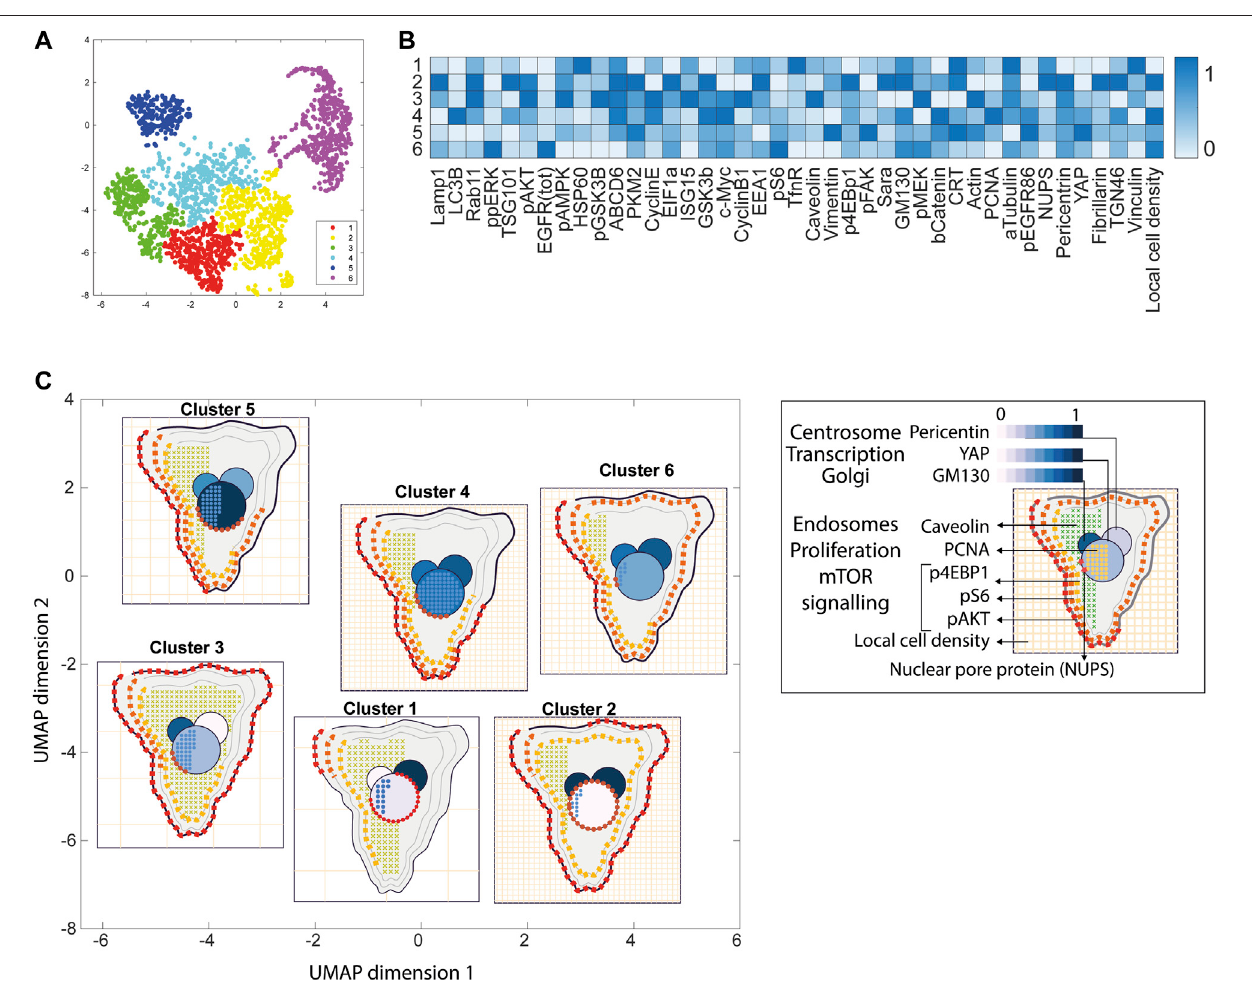
FIGURE 4 | ShapoGraphy allows interpreting multiplexed single-cell data. (A) UMAP projection of 2000 single HeLa cells. (B) Representation of average values of 40markersaswellaslocalcelldensityforeachidenti fi edclusterusingaheatmap. (C) RepresentationofselectedfeaturesfromCusingShapoGraphywheretheshapes graphs are placed at centre of the